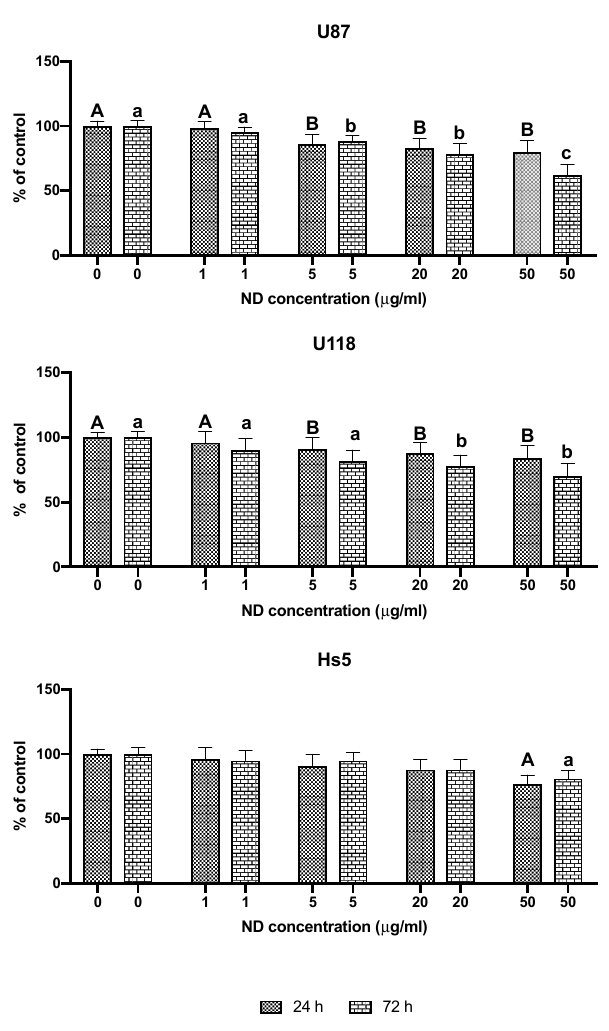
Figure 3. Viability of Hs5, U87, and U118 cells after treatment with nanoparticles of diamond (NDs) at concentrations of 1, 5, 20, and 50 µ g / mL for 24 and 72 h. Groups marked with di ff erent letters (A, B for 24 h treatment and a, b, c for 72 h treatment) are significantly di ff erent ( p < 0.05). The percentage of apoptotic cells (early and late in total) (Figure 4) increased to 14.5 and 25.2% after treating the U87 cells with 50 μ g/mL of ND for 24 and 72 h, respectively; in the case of U118 cells, the percent increased to 9.5 and 20.6% after 24 and 72 h, respectively. These results demonstrate the ability of NDs to induce apoptosis in U87 and U118 cells in a time-dependent manner. In Hs5 cells, apoptosis/necrosis was induced with 50 μ g/mL of NDs for 72 h; however, the percentage of dead cells was lower than in the U87 and U118 groups.